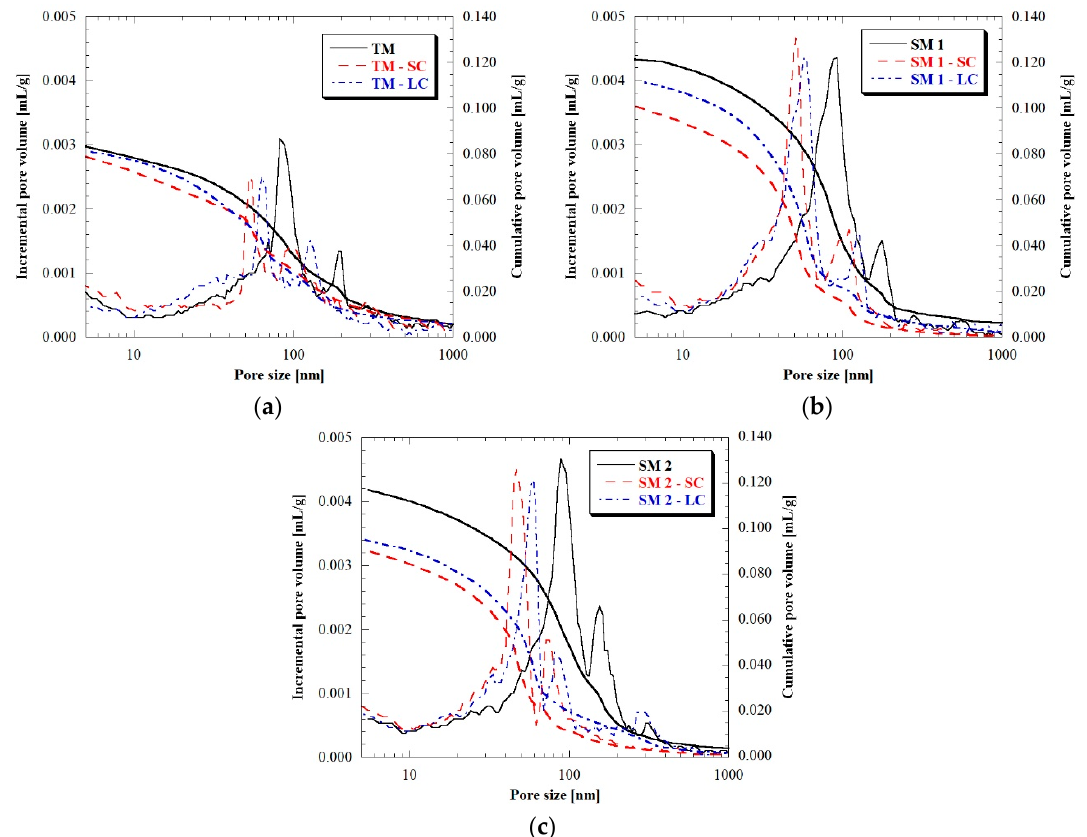
Figure 3. Intruded Hg volume vs. pore size for mortar TM ( a ), SM1 ( b ) and SM2 ( c ) with different admixtures (cumulative values in thick line).